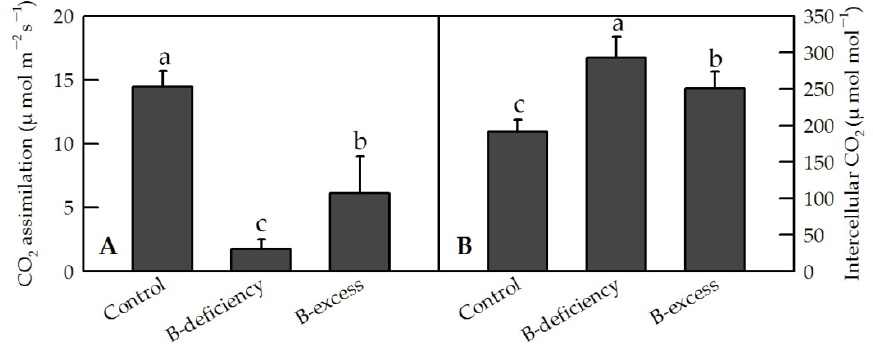
Figure 3. Effects of B deficiency and B excess on leaf CO 2 assimilation ( A ) and intercellular CO 2 concentration ( B ) in C. sinensis . Seedlings of C. sinensis were treated with 10 (Control), 0 (B-deficiency) and 400 µ M (B-excess) H 3 BO 3 for 15 weeks, respectively. Bars represent means ± SD ( n = 4). Differences among the treatments were analyzed by ANOVA. Different letters above the bars indicate a significant difference at p < 0.05.